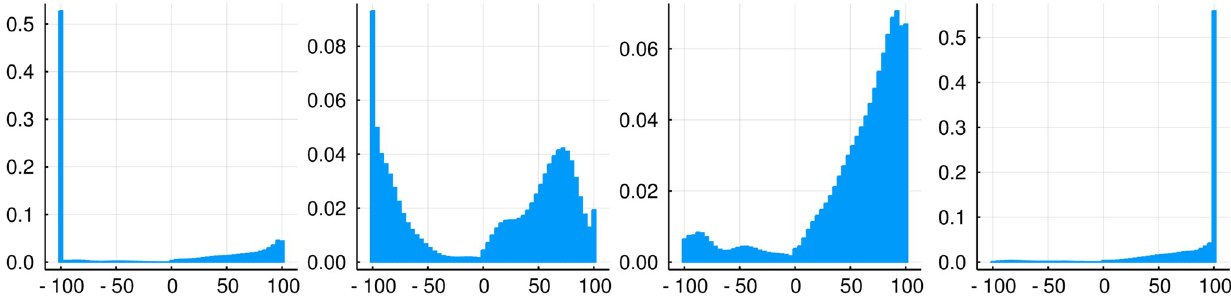
Fig 4. Examples of return distributions when following the clinicians’ policy. From left to right: negative outcome, bimodal distribution, slightly bimodal distribution, positive outcome.